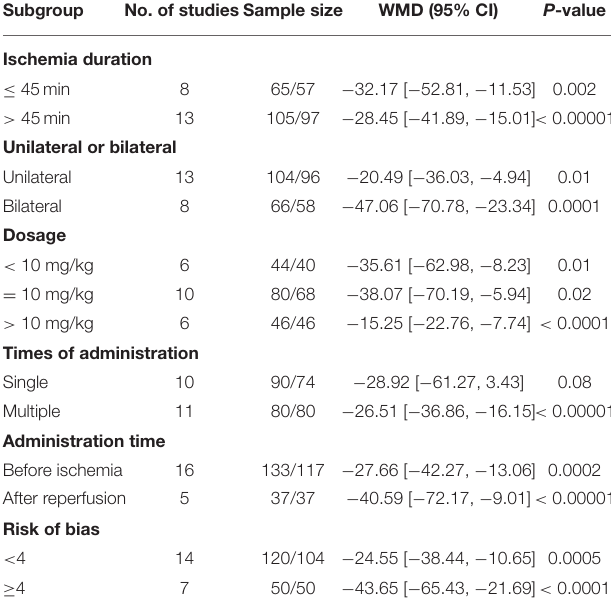
TABLE 3 | Subgroup analysis of pooled estimates of